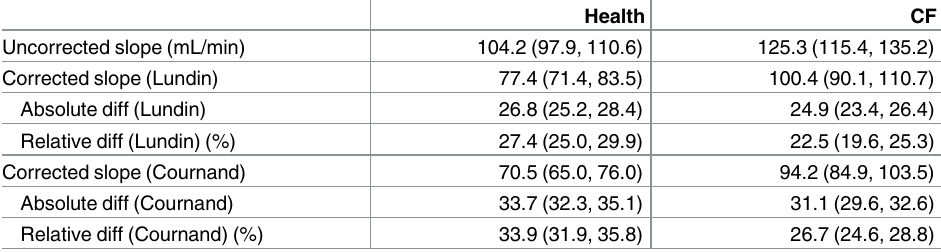
Table 4. Average slopes of the second half of all uncorrected, Lundin-corrected and Cournand-cor- rected FRC N2 /breath number curves (depicted graphically in Fig 4) for healthy subjects and those with CF. Average paireddifference (uncorrected-corrected) in absolute and relative(percent of uncorrected slope) terms are shown. Data are expressedas mean 95% confidenceinterval) unless